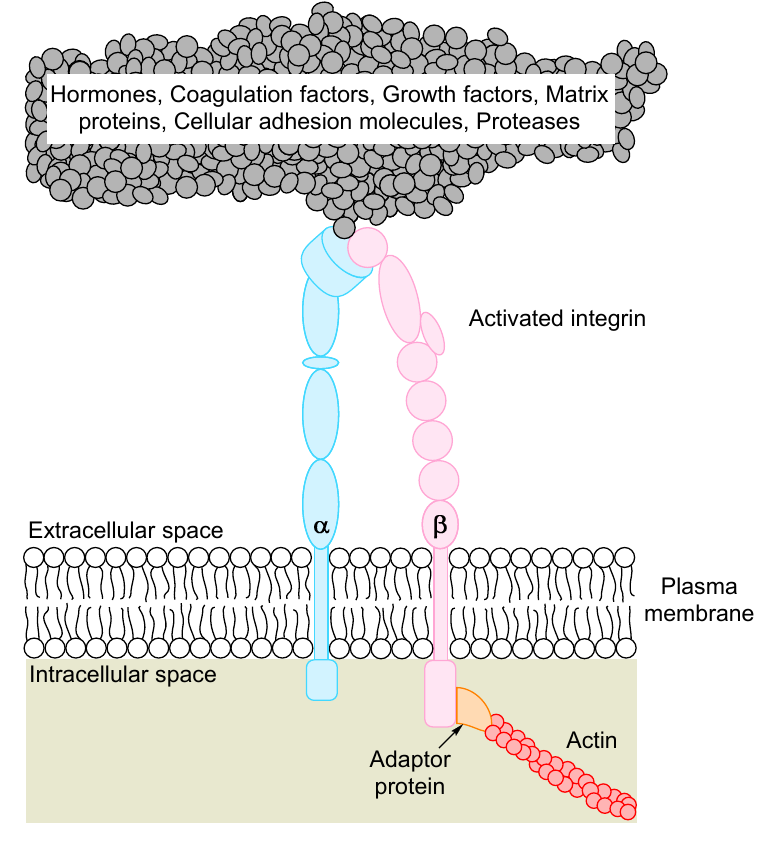
Figure 1. The integrin heterodimer consisting of one α and one β chain. In its activated state, the heterodimer interacts with the extracellular matrix through binding to large structural proteins such as collagen or fibrinogen, or with receptors on neighboring cells. The short cytoplasmic tail interacts with a vast variety of ligands, with members of the cytoskeleton comprising the largest subgroup. The main classification of ligands is shown at the top of the figure (for details see Table 1).